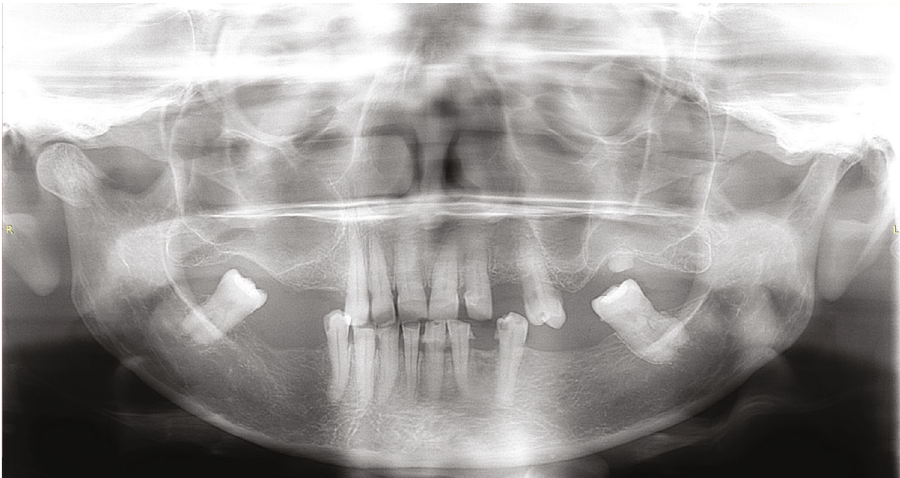
Figure 1: Panoramic radiograph demonstrating the condylar fracture on the right